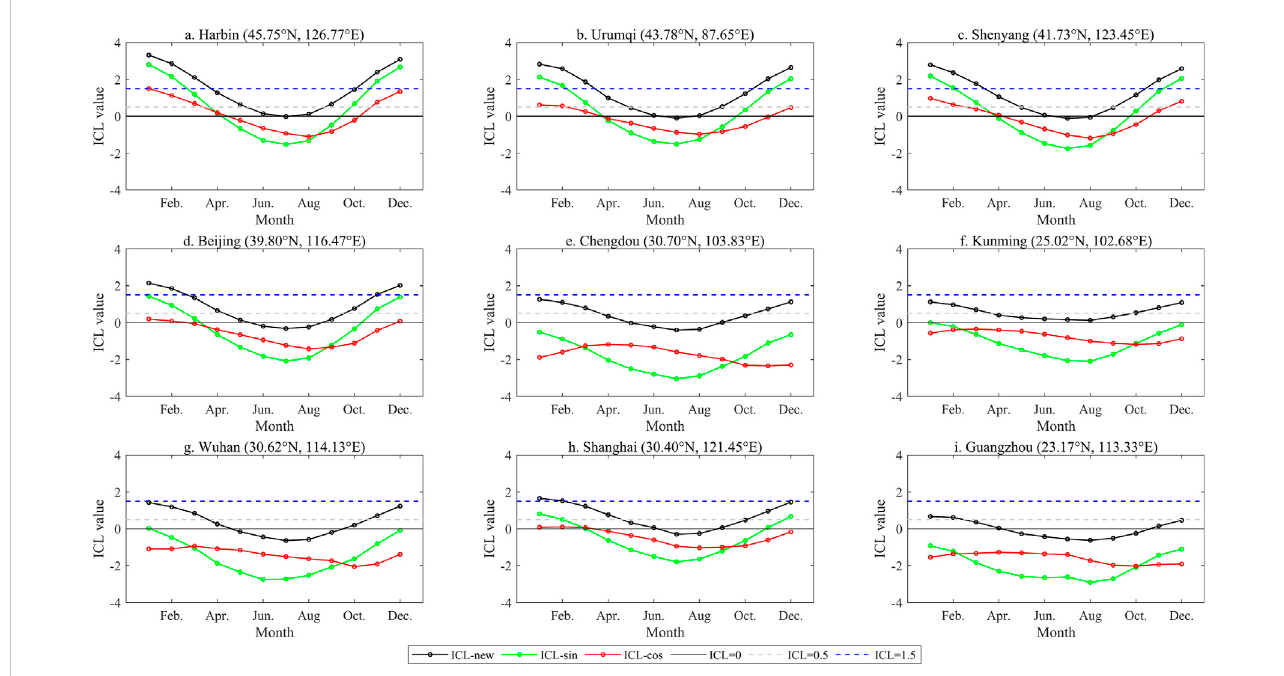
FIGURE 3 Comparison of multi-year monthly average ICL calculated by three methods in nine cities from 1981 to 2010. Lables ( A – I ) represent nine cities, Harbin, Urumqi, Shenyang, Beijing, Chengdou, Kunming, Wuhan, Shanghai, Guangzhou, respectively.